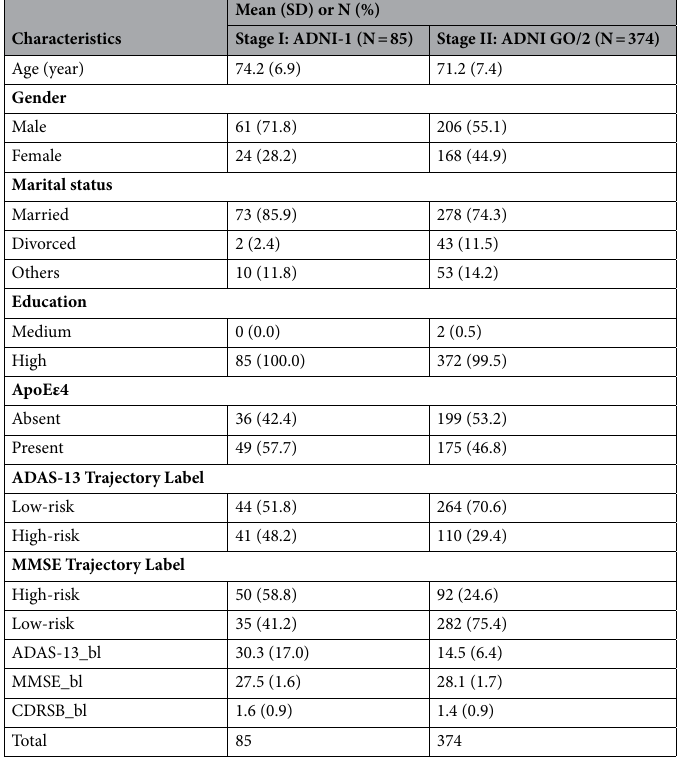
Demographics. Table 1 shows the baseline demographic characteristics (age, gender, marital status, and trajectory label) of subjects in two stages. Of the 85 subjects in stage I (trajectory dataset), 35 (41.2%) pro- gressed to AD over the 3 years of follow-up, with the mean time to onset of AD being 20.4 ± 8.5 months (range